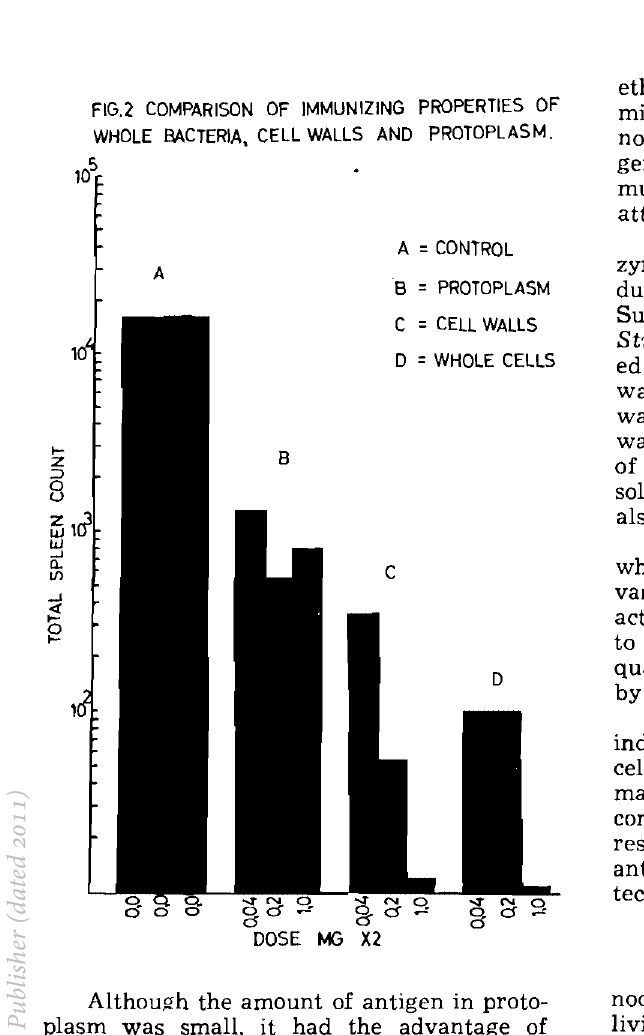
FIG.2 COMPARISON OF IMMUNIZING PROPERTIES OF WHOLE BACTERIA, CELL WALLS AND